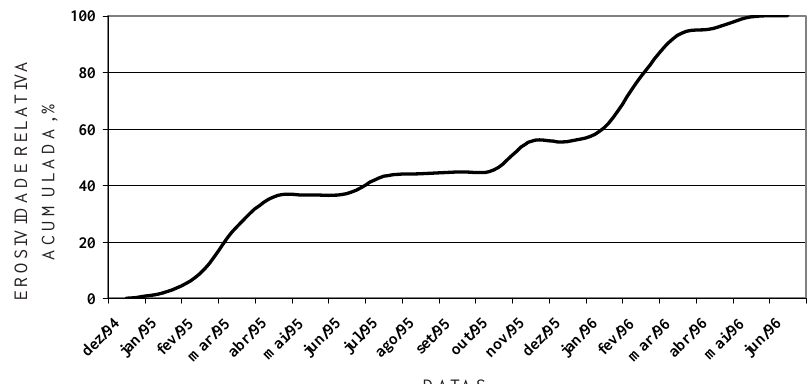
Figura 1. Distribuição relativa acumulada temporal da erosividade (índice EI experimental (ciclos culturais da soja avaliados para erosão: 8/12/94 a 6/04/95 e 30/12/95 a 7/05/96; ciclo cultural da aveia preta avaliado para erosão: 11/05/95 a